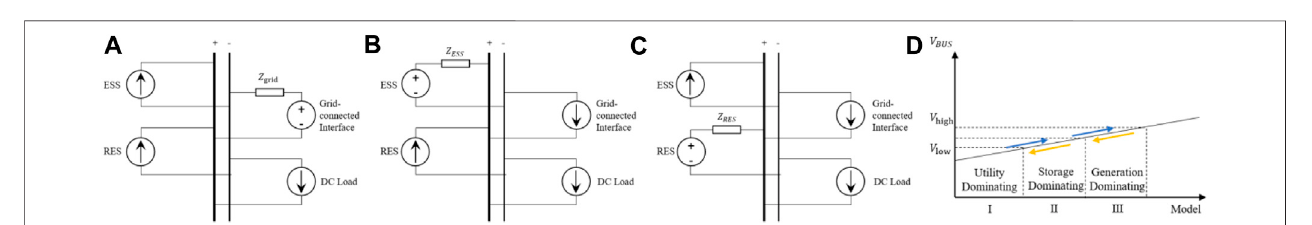
Frontiers in Energy Research |